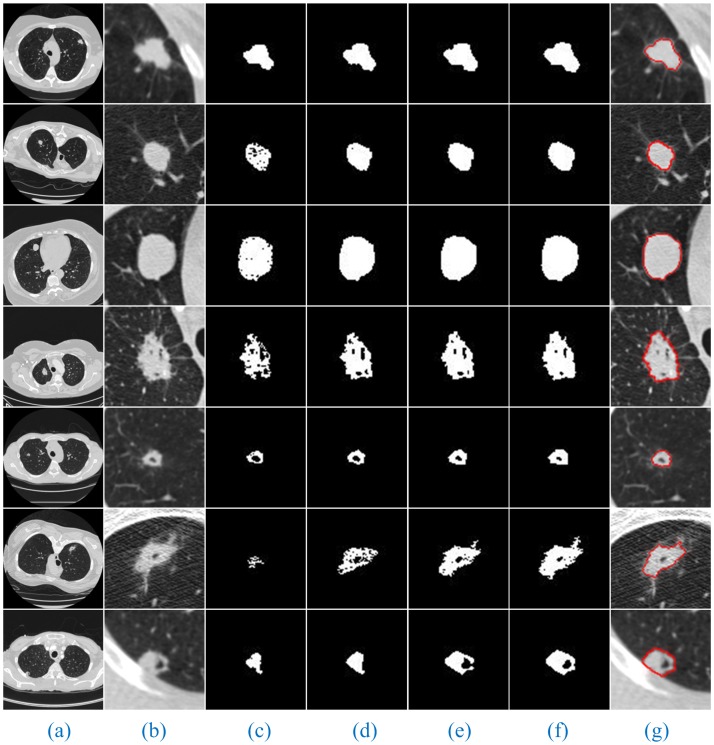
The segmentation results of RG for solitary pulmonary nodules and cavitary nodules.Column (a) shows the original lung CT images, (b) shows the results of the local enlargement of (a), (c)-(f) show the segmentation results of lung nodule image masks when the gray threshold is 0.05, 0.1, 0.15 and 0.2 (/255), and (g) shows the results of manual segmentation by experts.